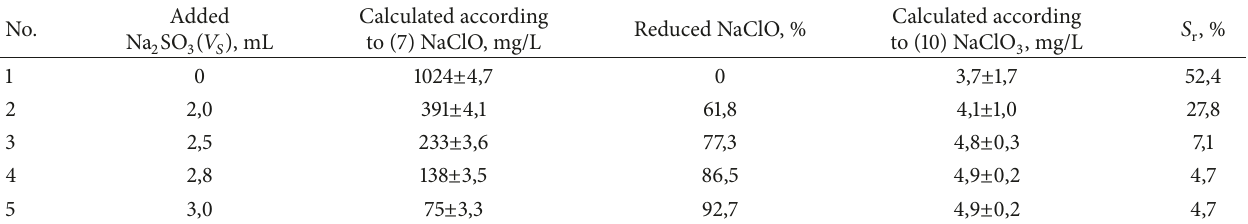
Table 4: The results of the determination of NaClO 3 in the standard solution of 1025 mg/L NaClO with 5 mg/L of NaClO 3 according to the procedure with the reduction of ClO − excess with 0.085 N Na 2 SO 3 ; V 0 = 10 mL; V NaOH = 0.5 mL; (N = 5, P = 0.95).